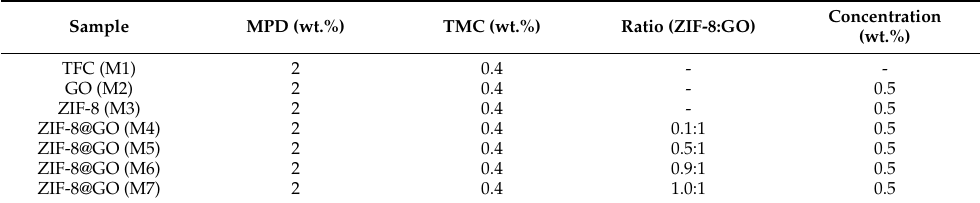
Table 2. Relative amounts of components used for the preparation of TFC